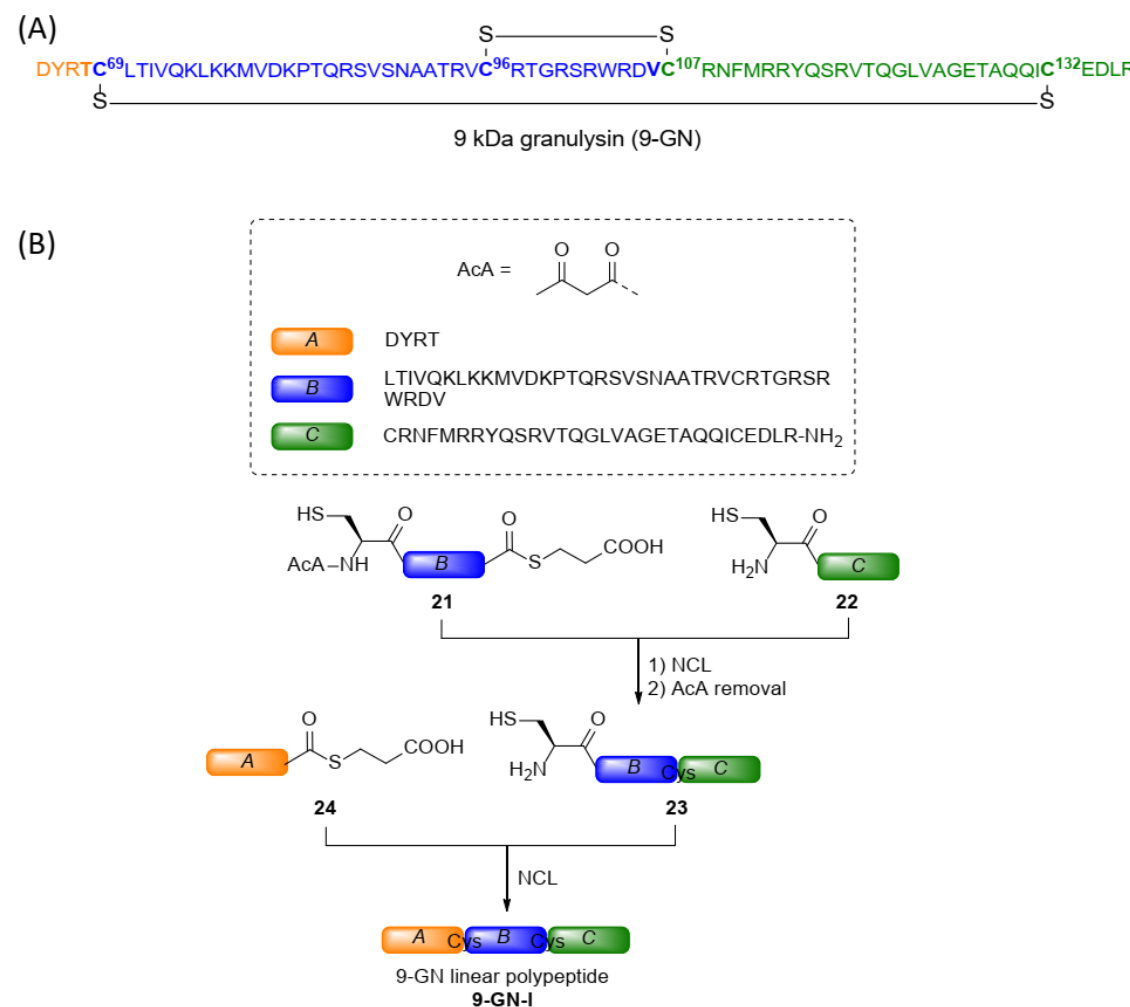
Figure 6. ( A ) Primary structure of 9 kDa granulysin (9-GN) and pattern of disulfide bonds. ( B ) General strategy used for assembling the linear 9-GN polypeptide ( 9-GN-l